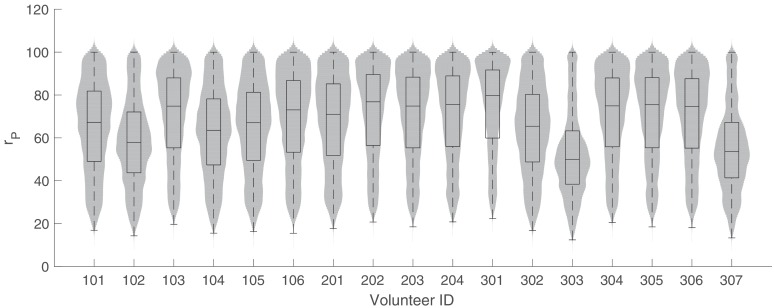
The marginal posterior distributions of the individual parameter of rP (parasite replication rate) for all 17 volunteers.The violin plots (gray area) show the distributions of 5000 posterior samples. Box plots show the 25%, 50% (median) and 75% quantiles with outliers indicated by red dots. Relevant details of the individual parameter are provided in the Materials and methods in the main text.